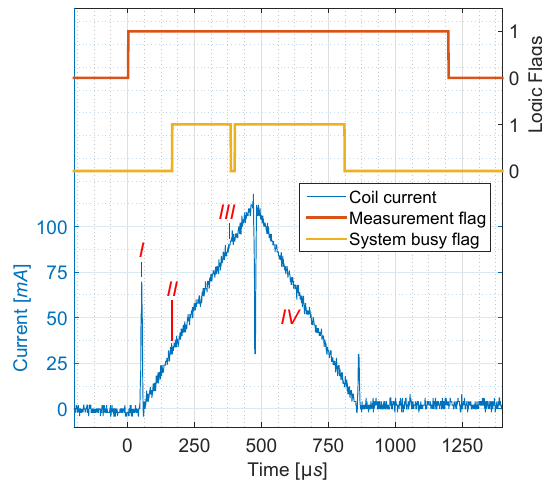
Figure 5. A typical current measurement cycle where the states of the internal logic flags have been plotted alongside the current measurement. The Roman numerals marks the start of each